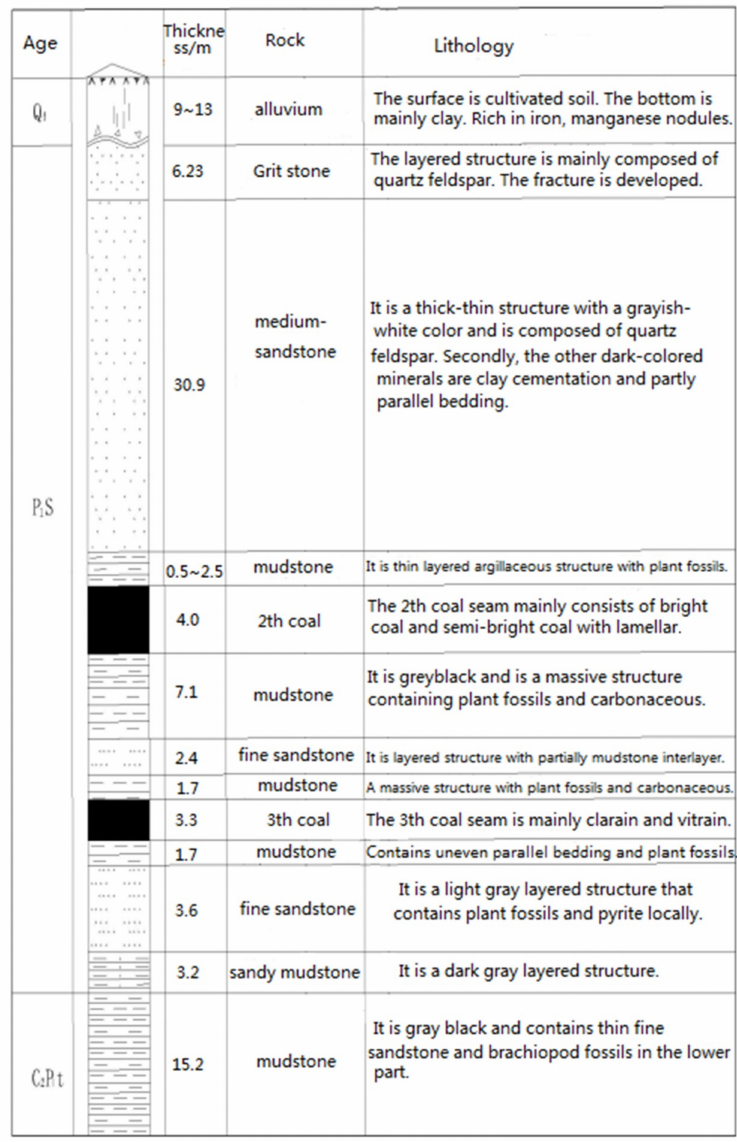
Figure 1. Strata comprehensive histogram of the Daxing Coal